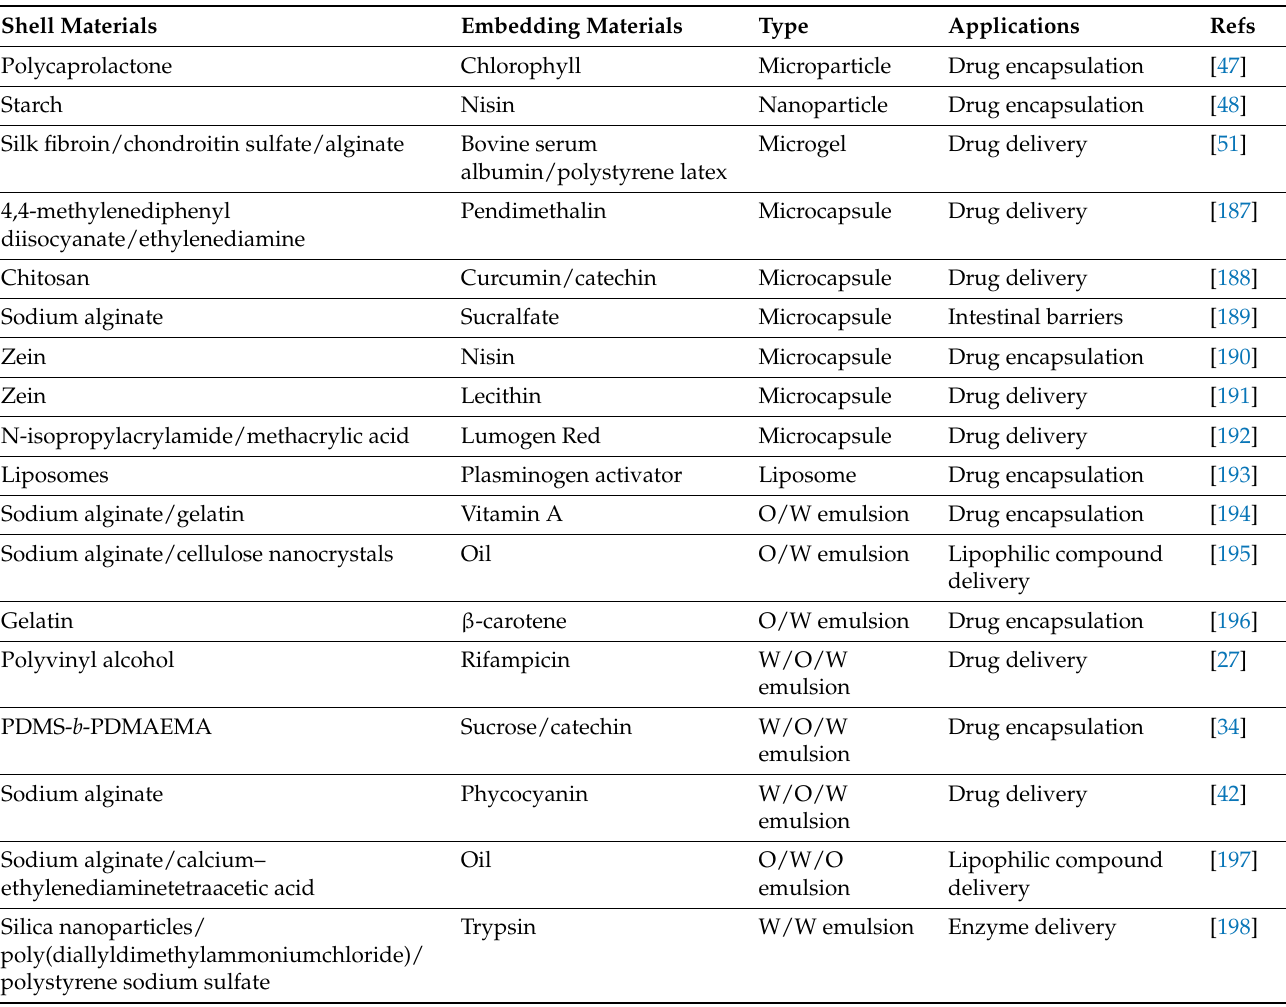
Table 4. Summary of the droplet microfluidics for emulsions and microcapsules in food processing and